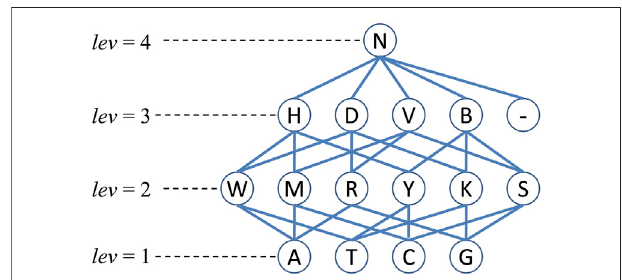
FIGURE 2 | The generalization hierarchy (Malin, 2005b) for sequence or nucleotide obfuscation. Note that lev is the level of corresponding nucleotides and the symbol “ - ” represents the